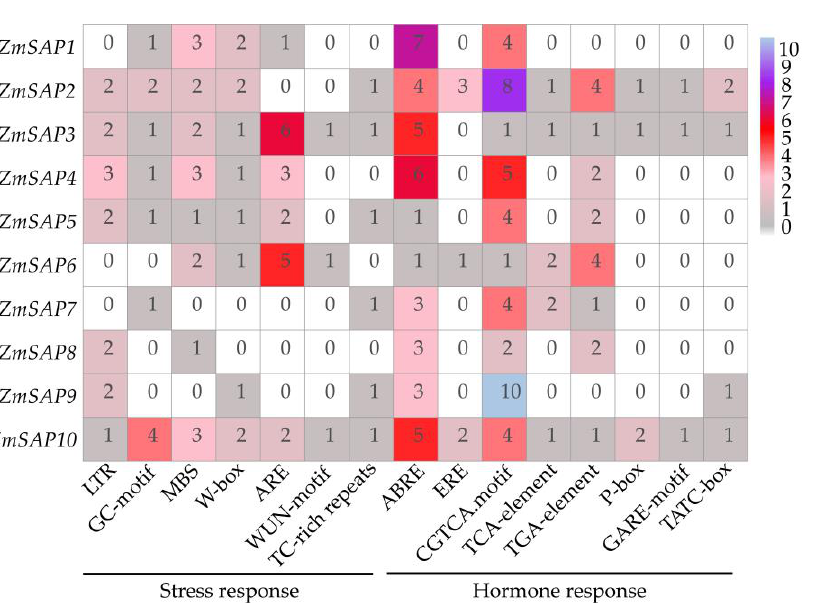
Figure 5. The cis -acting elements ZmSAP promoter region. The numbers in the blocks represent the number of cis -acting elements. LTR — low-temperature response; GC-motif — enhancer-like element number of cis -acting elements. LTR—low-temperature response; GC-motif—enhancer-like element involved in anoxic specific inducibility; MBS — (Myb binding site) drought response; ARE — (anaer- involved in anoxic specific inducibility; MBS—(Myb binding site) drought response; ARE—(anaerobic obic response element) anaerobic induction; TC-rich repeats and W-box — defense and stress re- response element) anaerobic induction; TC-rich repeats and W-box—defense and stress sponse; WUN-motif — wounding response; ABRE (ABA response element) — ABA response; ERE